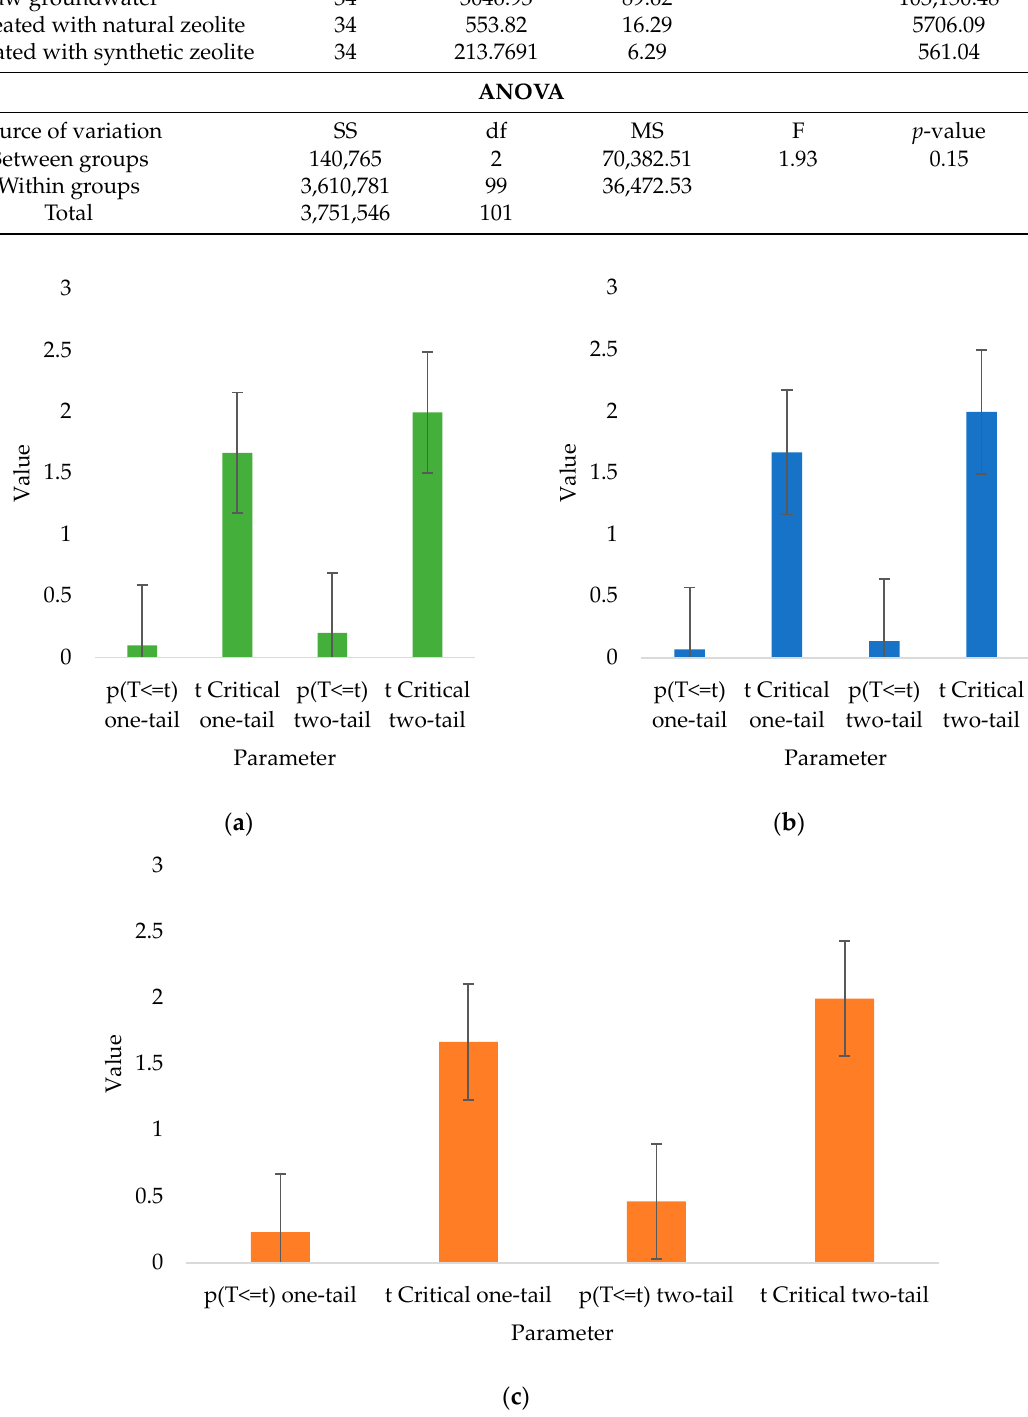
Figure 2. Results of the t -test analysis: ( a ) raw groundwater vs. effluent treated with natural zeolite; ( b ) raw groundwater vs. effluent treated with synthetic zeolite; ( c ) effluent treated with natural zeolite vs. effluent treated with synthetic zeolite.